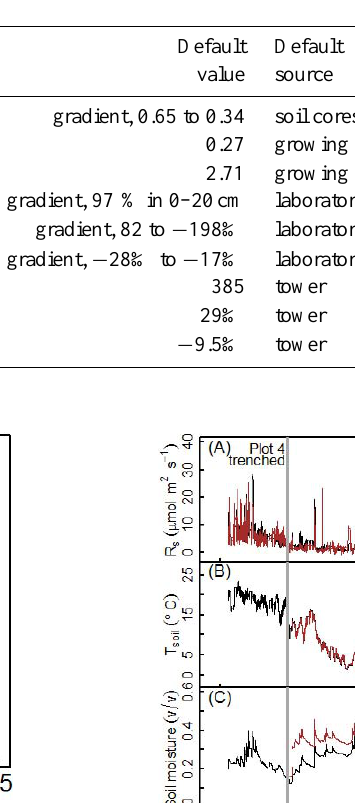
Table 1. Default parameters in model simulations.